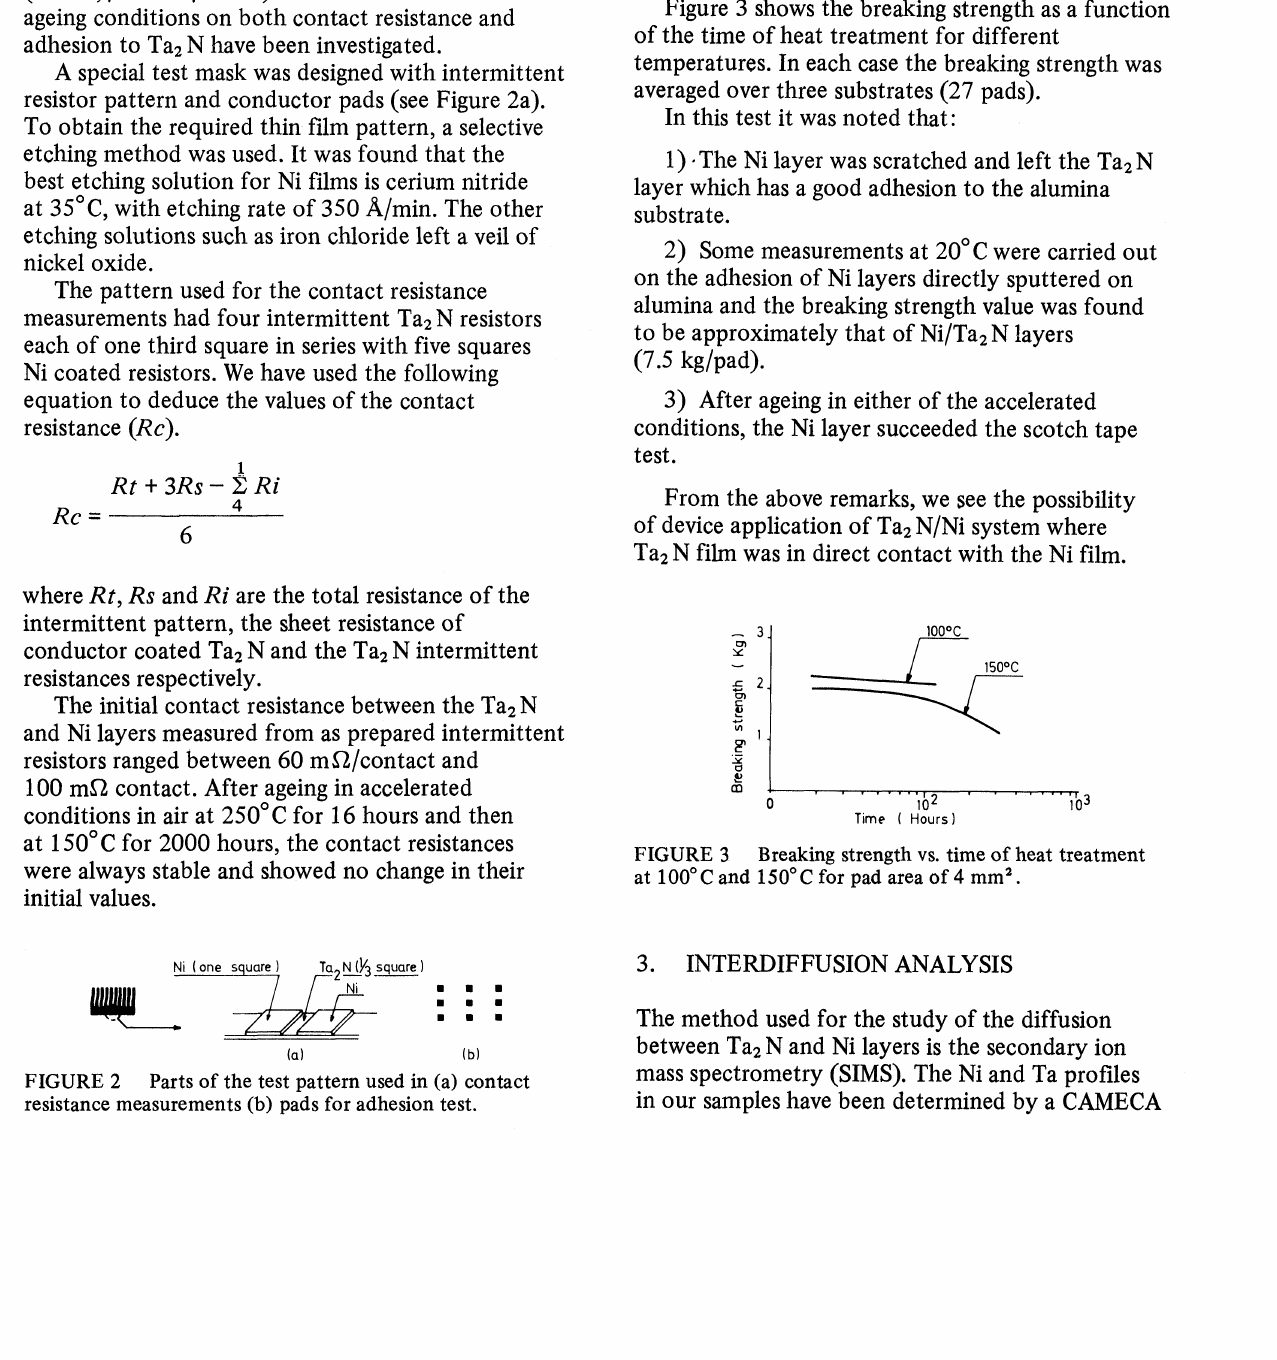
FIGURE 2 Parts of the test pattern used in (a) contact resistance measurements (b) pads for adhesion